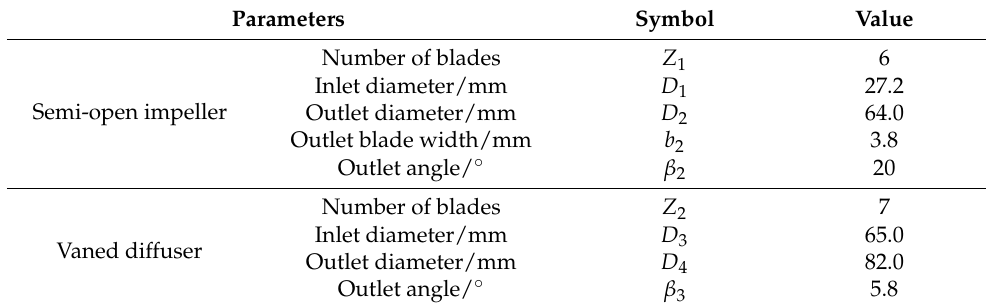
Table 1. Structural parameters of hydraulic components of pump.